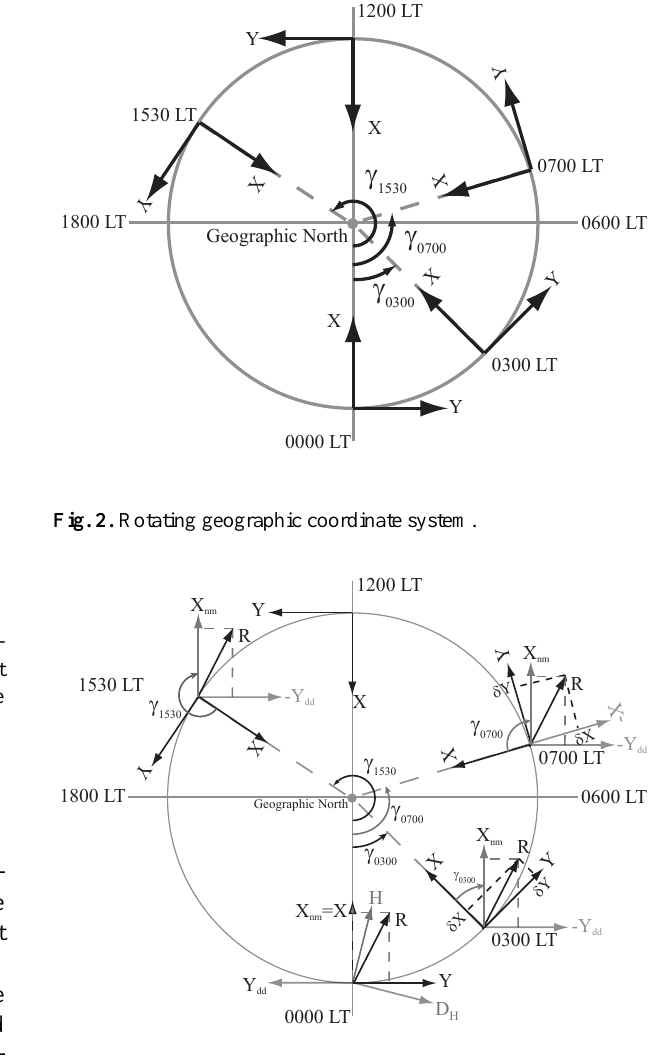
Fig. 3. Rotation of the geographic coordinate system with respect to invariant local time for a constant disturbance vector R